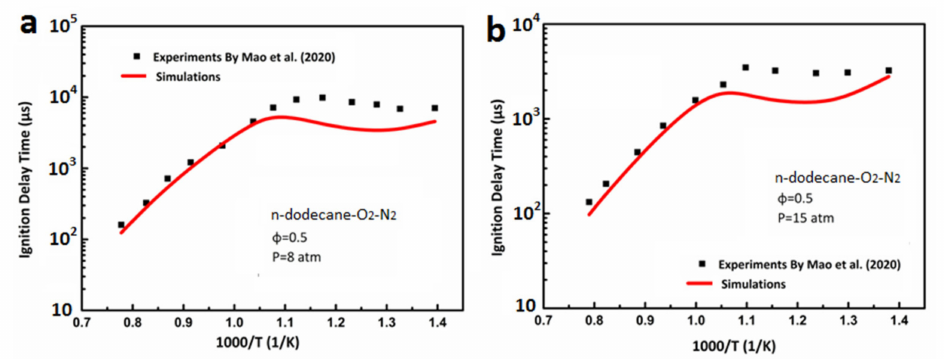
Figure 1. ( a ) Comparison of simulated and experimental ignition delay time of n-dodecane at Φ = 0.5, 8 atm; ( b ) Comparison of simulated and experimental ignition delay time of n-dodecane at Φ = 0.5, 15 atm.